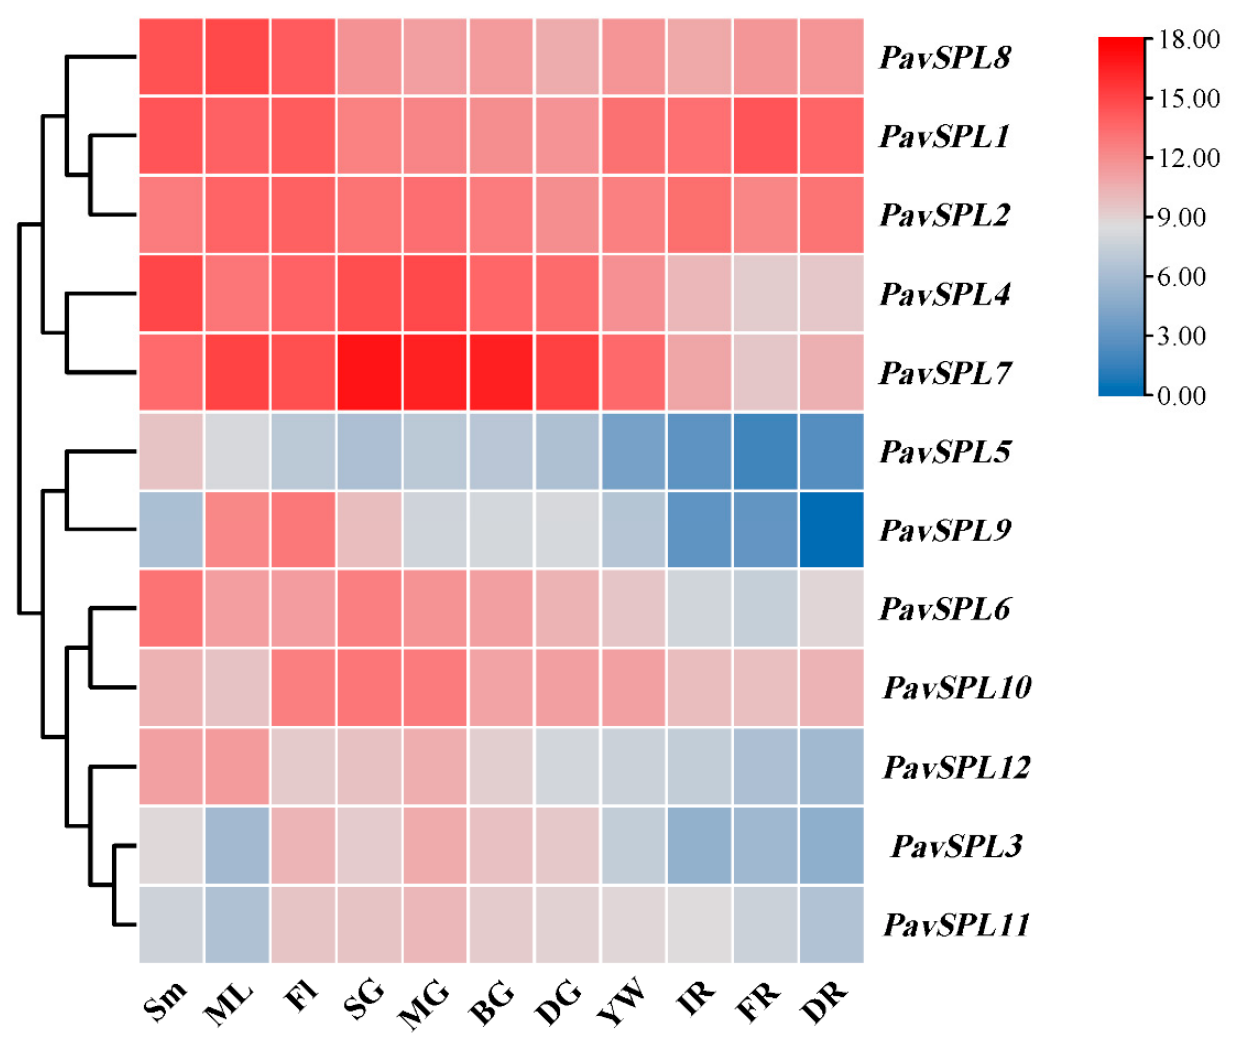
Figure 7. The expression quantities of PavSPLs in different tissues as assessed using TBtools. Sm: stems; ML: mature leaves; SG: small green; MG: mid green; BG: big green fruit; DG: de-greening; YW: yellow fruit; IR: initial red; FR: full red fruit; DR: dark red. The relative mRNA levels are represented as the means ± SDs ( n = 3). Statistically significant differences were assessed using Student’s t -test.